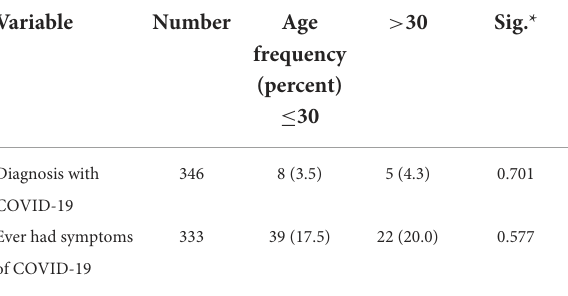
TABLE 7 Relationship between COVID-19 anamnesis and age among respondents of self-reported side effects of COVID-19 vaccines, Ethiopia, 2021.